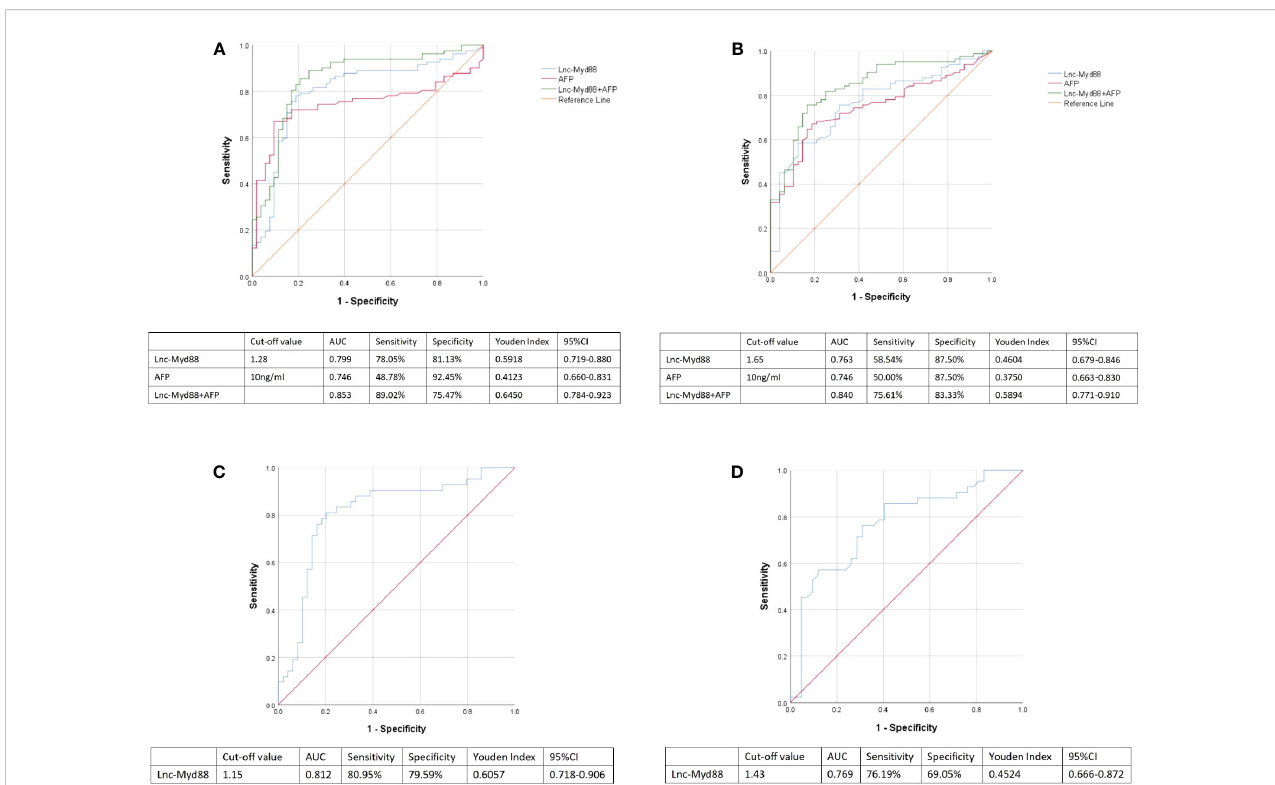
FIGURE 3 (A) ROC curves were used to analyze the sensitivity, speci fi city, Youden index, and area under the curve (AUC) of lnc-MyD88 and AFP alone and in combination for the diagnosis of HBV-associated HCC. Healthy people were set as control. (B) ROC curves were used to analyze the sensitivity, speci fi city, Youden index, and AUC of lnc-MyD88 and AFP alone and in combination for the diagnosis of HBV-associated HCC. LC patients were set as control. (C) The ROC curve of plasma lnc-MyD88 for the diagnosis of AFP-negative HCC was plotted using healthy people as the control group. (D) The ROC curve of plasma lnc-MyD88 for the diagnosis of AFP-negative HCC was plotted using LC patients as the control group. LC, Liver cirrhosis; HCC: Hepatocellular carcinoma; HBV, Hepatitis B virus; Lnc-Myd88, Long noncoding